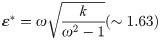
Transition between regimes of stable origin and escaping trajectories.Bifurcation diagram (black dots) along with the largest eigenvalue (red symbols) as a function of ε in the top row. ε*=ωkω2-1(∼1.63) marks the coupling beyond which all initial conditions lead to escaping trajectories in region E. Transient trajectories shown for ε(= 0.5) < ε* (left bottom) and ε(= 1.75) > ε* (right bottom).